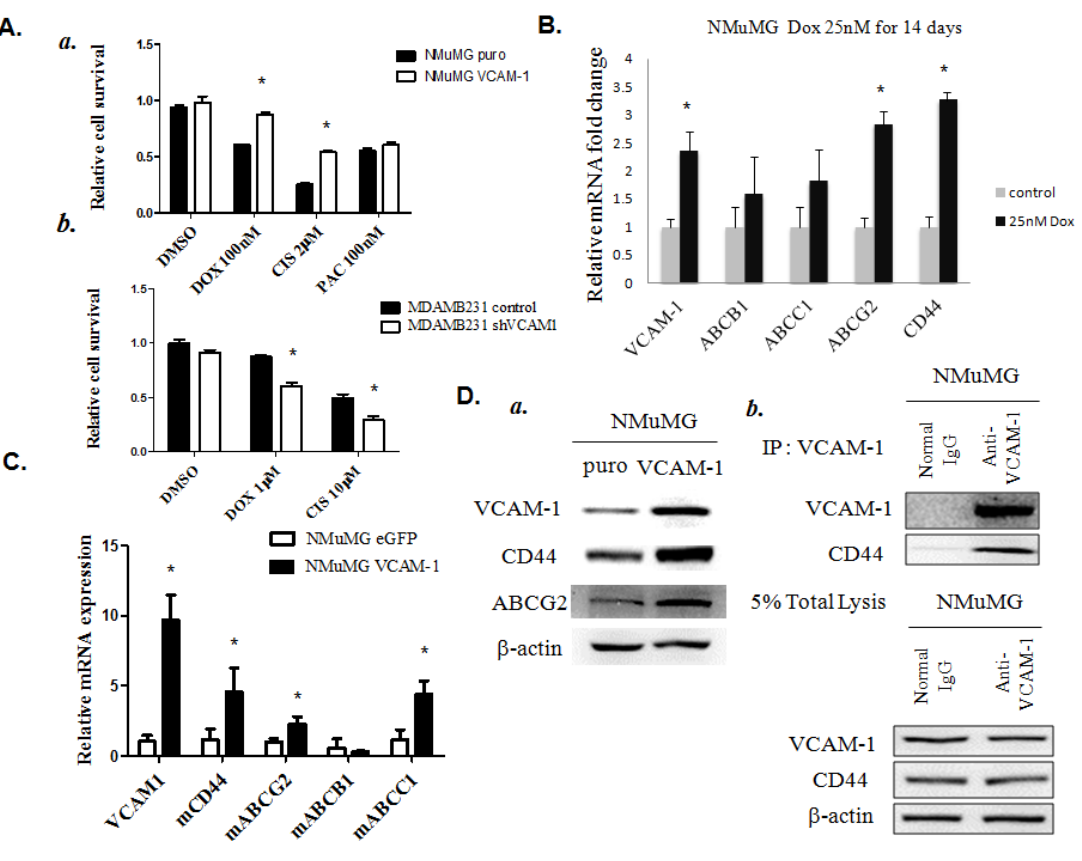
Figure 6. ( A ) VCAM-1 over-expression contributes to increased chemoresistance in a , NMuMG and b , MDAMB231 cells by MTT analysis. S amples were analyzed after 48 h of drug treatment, * p < 0.01; ( B ) Increased chemoresistance markers and VCAM-1 expression in NMuMG cells after long-term exposure to low-dose doxorubicin. Relative mRNA levels are expressed as arbitrary units normalized to the data from controls, * p < 0.01; ( C ) VCAM-1 regulates migration and chemoresistance-related genes in NMuMG cells as determined by RT-qPCR, * p < 0.01; ( D ) Over-expression of VCAM-1 increases CD44 and ABCG2 protein levels, and VCAM-1 physically interacts with CD44 molecules in control and VCAM-1 -over-expressing NMuMG cells as determined by western blot and immunoprecipitation